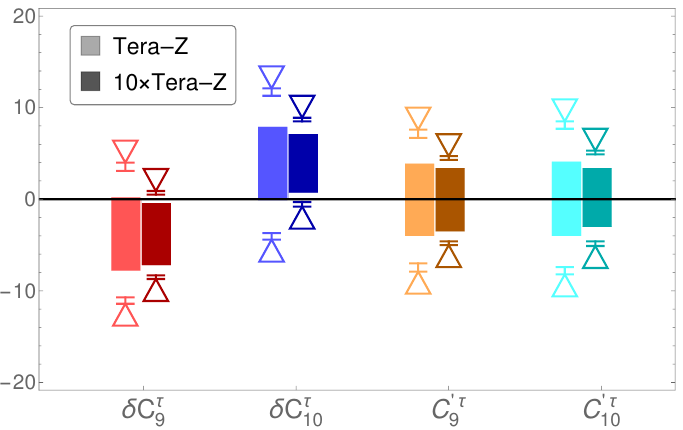
and C 0 τ at the future Z factories. 9 , 10 9 , 10